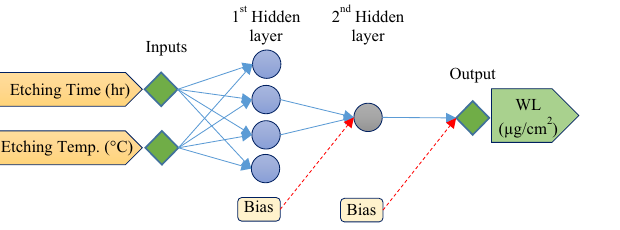
Figure 9. A schematic ANN model structure for WL prediction based on etching time and solution temperature.